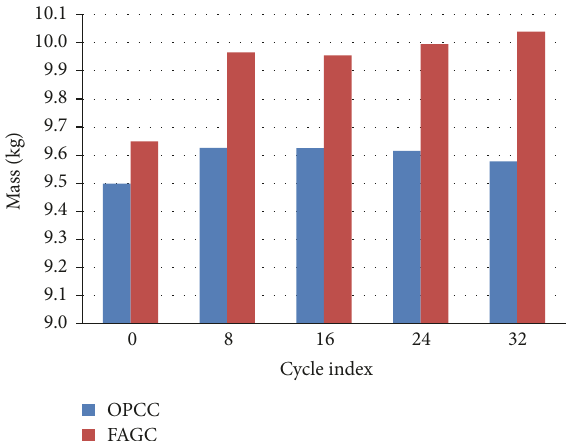
Figure 6: The mass change of OPCC and FAGC samples with the cycle index.